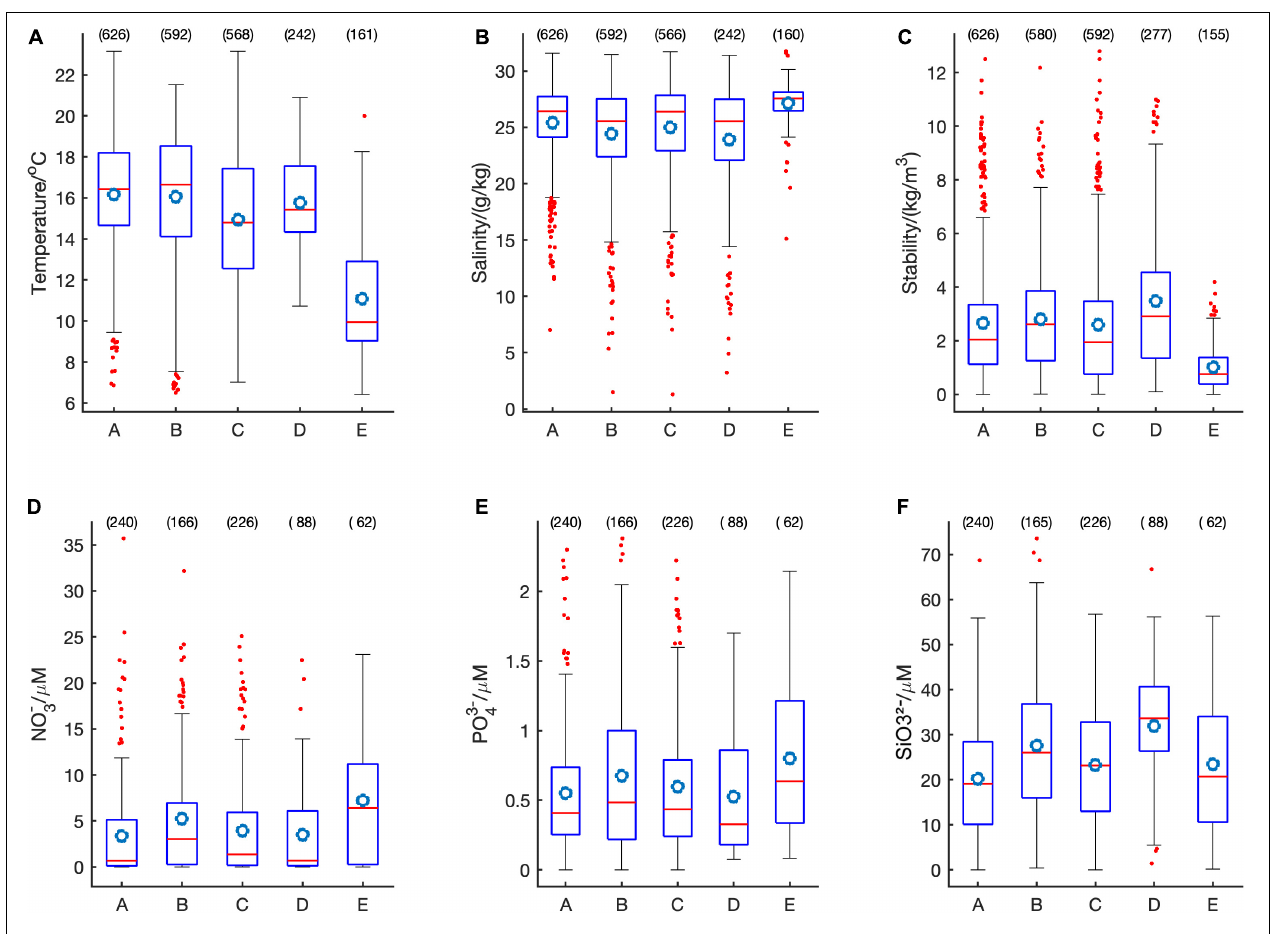
FIGURE 7 | Boxplots for temperature (A) , salinity (B) , stratification parameter (C) , nitrates (D) , phosphates (E) , and silicates (F) for Rhizosolenia setigera (A) , Dictyocha spp. (B) , Alexandrium spp. (C) , Heterosigma akashiwo (D) , Chaetoceros convolutus and C. concavicornis (E) . Within each box, the horizontal red line denotes median values and the circle represents mean; boxes extend from the 25th to the 75th percentile; vertical lines denote adjacent values within 1.5 interquartile range of the 25h-75 percentile of each group; red dots denote observations outside the range of adjacent values; the number above each box represents quantity of data points.